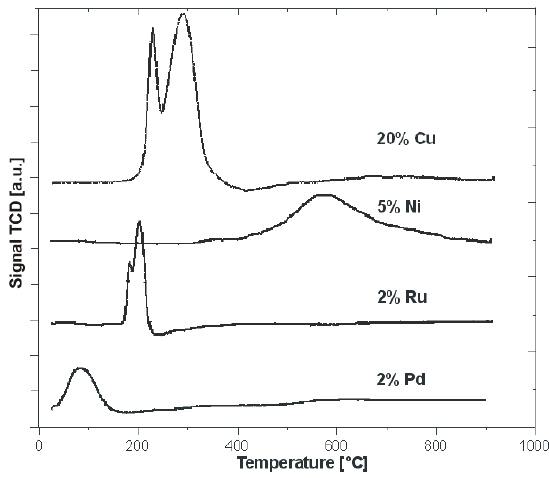
Figure 3. TPR profiles of Cu, Ni, Ru, Pd supported catalysts after calcination in air for 4 h at